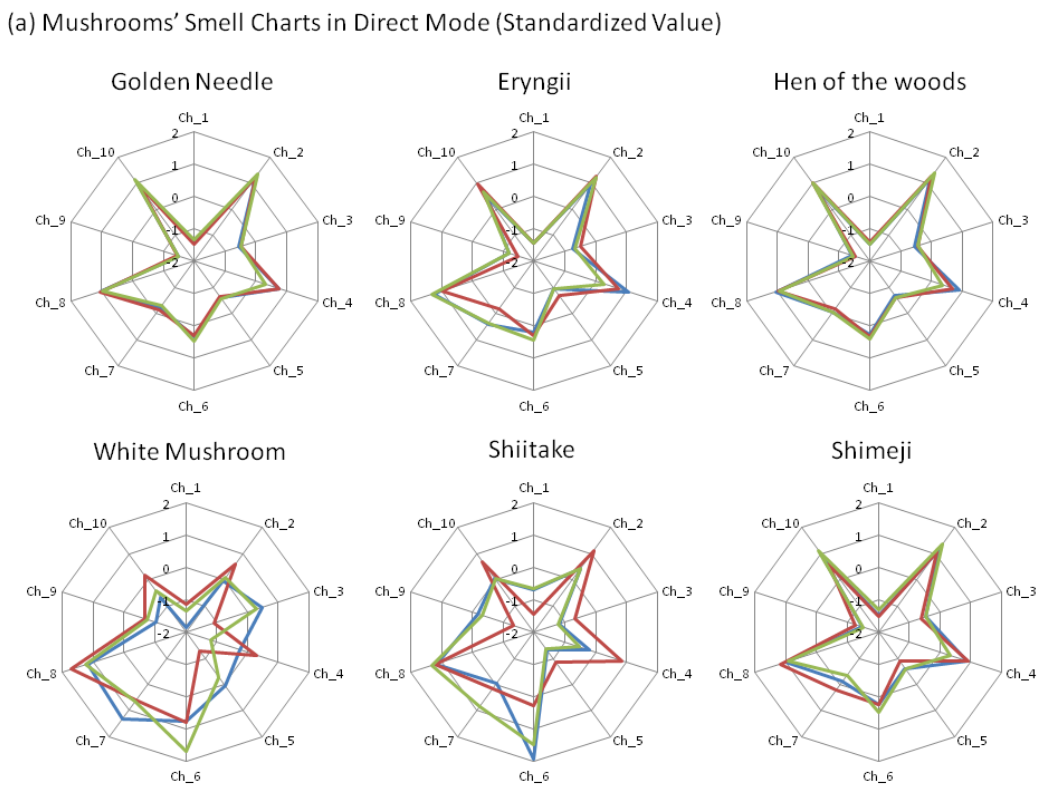
Figure 4. Standardized values in ( a ) direct mode; ( b ) capture mode; ( c ) subtraction values. (Blue: 1st trial, Red: 2nd trial, Green: 3rd